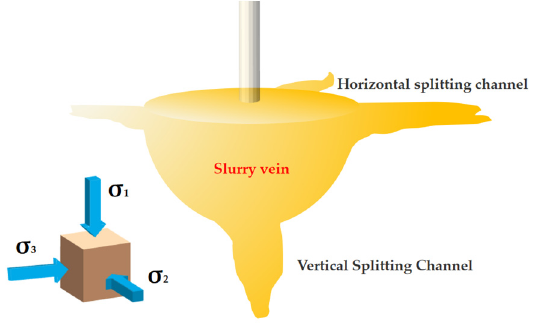
Figure 14. Schematic diagram of sand grouting splitting surface.